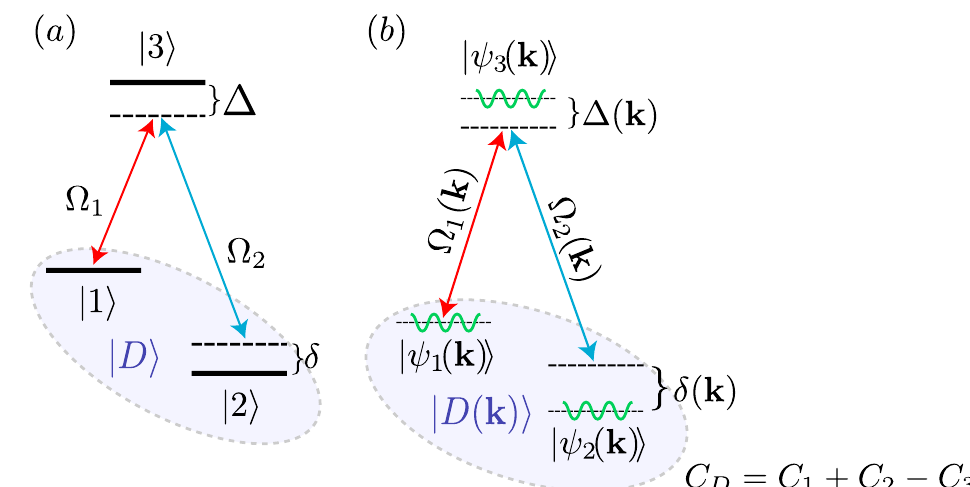
Figure 1: (a): The Λ scheme involving three discrete levels. The Rabi couplings Ω 1,2 and frequency detunings ∆ and δ are indicated; see Eq. (2). A stable dark state | D 〉 is created when δ ≈ 0; see Eq. (3). (b) The Λ scheme involving three Bloch bands ( k ) . The detunings and Rabi frequencies depend on the quasimomentum k of E 1,2,3 the Bloch states. The Chern number of the resulting “dark band” C follows a simple D sum rule in terms of the Chern numbers C of the bare 1,2,3